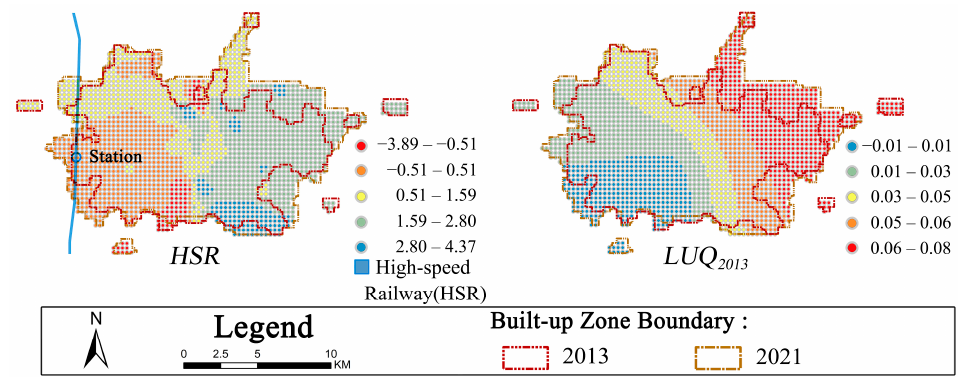
Figure 8. Heterogeneity impact of local factors on